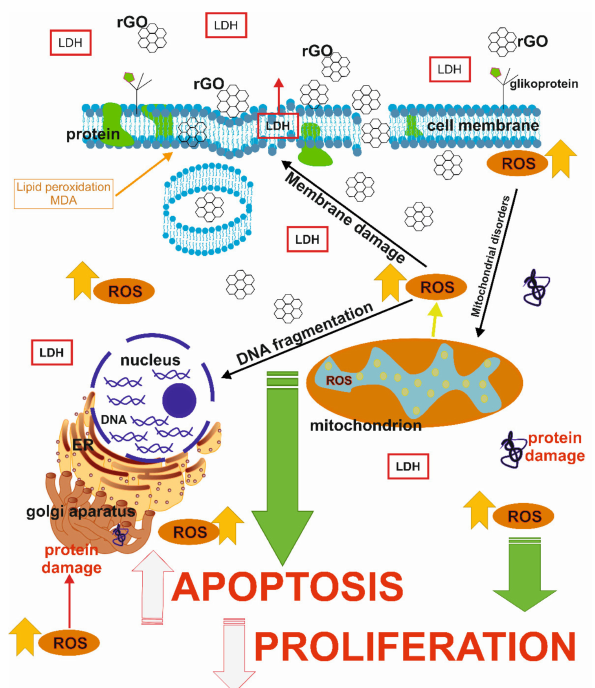
Figure 6. The effect of rGO on cytotoxicity, oxidative stress, apoptosis and proliferation in breast cancer cells. Abbreviation: rGO—reduced graphene oxide; ROS—reactive oxygen species; LDH—lactate